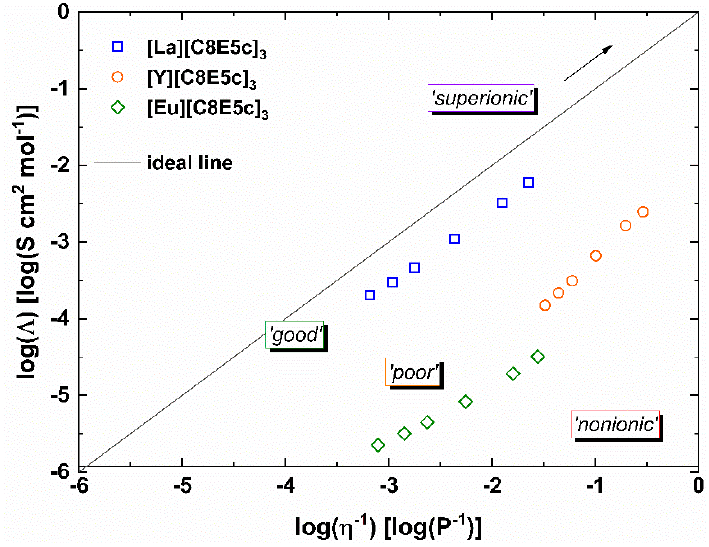
Figure 2. Walden Plot of selected rare earth metal ionic liquids in a range of 15–60 °C in comparison to the ideal KCl line, adapted from Reference [9] (Copyright © 2021 Wiley–VCH GmbH, Weinheim).